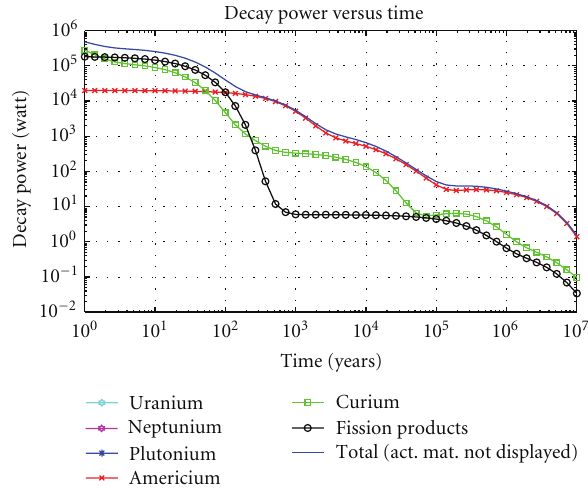
Figure 28: Contributions to heatload versus time—GCFR SNF end third cycle.